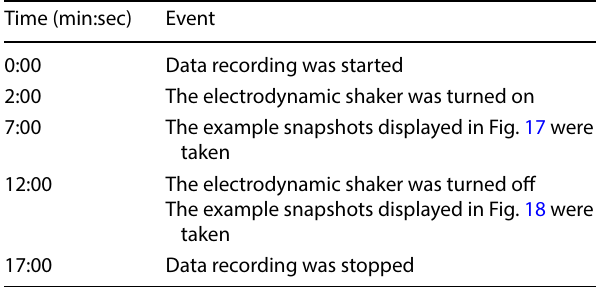
Table 3 Natural frequency and damping ratio of the 10th mode of vibration at different bolt load levels